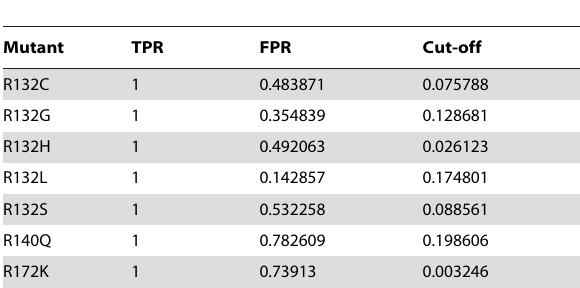
Table 1. Cut-off values determined based on the ROC analysis. TPR-true positive rate (equivalent to sensitivity), FPR- false positive rate (equivalent to 1-specificity).